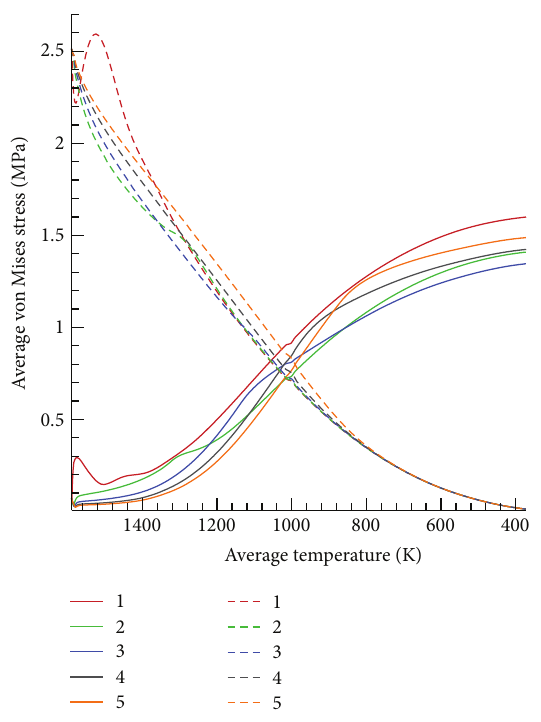
Figure 7: Average residual stress of plastic body (solid lines) and elastic body (dashed lines) versus the average temperature during the cooling